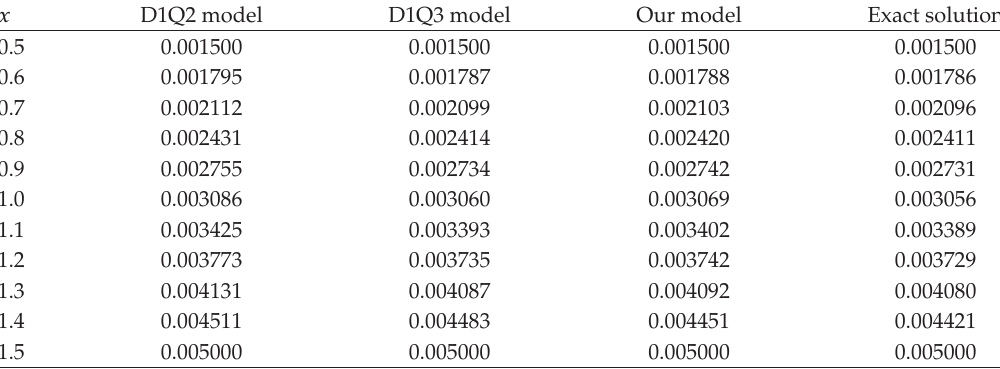
Table 4: Comparison of the results with D1Q2, D1Q3, our model, and exact solution.